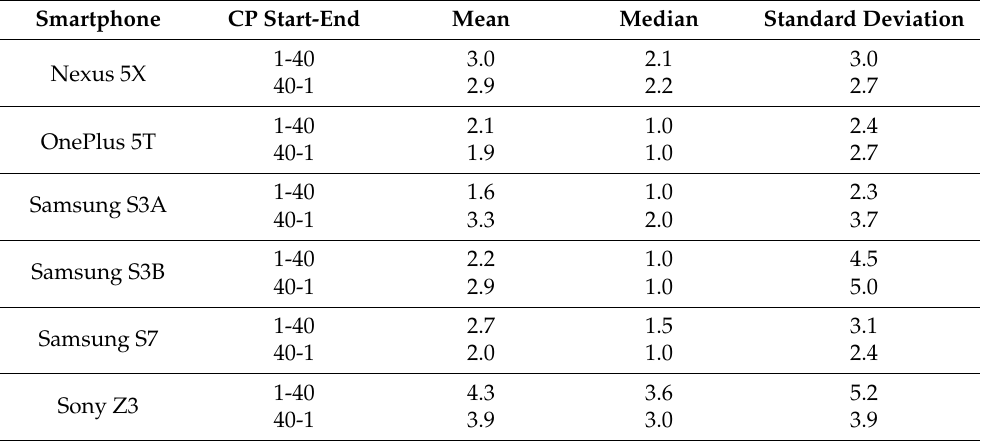
Table 9. Deviations in [m] from the ground truth in dependence of the smartphone for the kinematic measurement